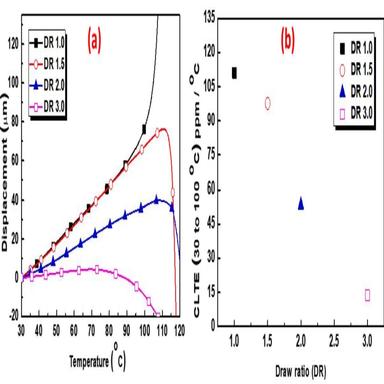
(a) The coefficient of linear thermal expansion graphs between 30 and 120 ◦C of the biaxially oriented PCTN films, (b) CLTE value of biaxially stretched PCTN film as a function of draw ratio.